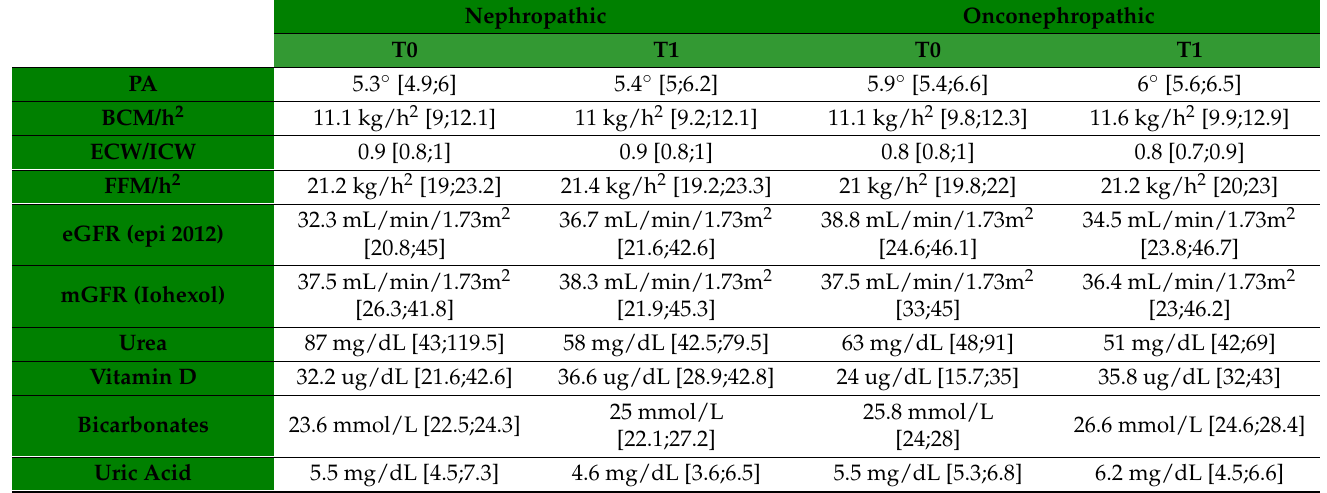
Table 7. Comparison between the response of each group to the NNCA treatment (annotations follow the format: mean [confidence